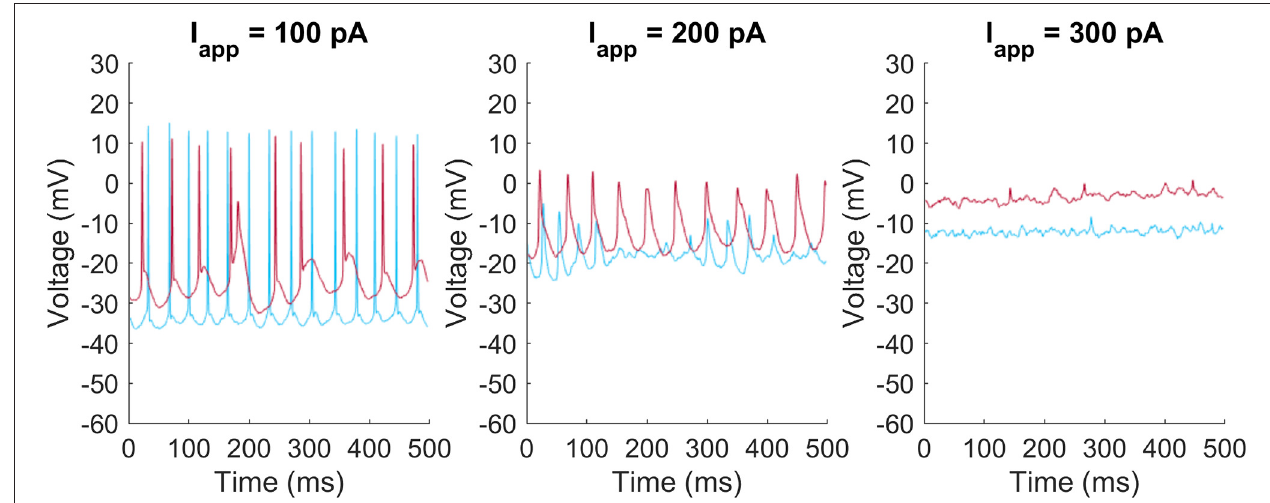
FIGURE 2 | Heterogeneity of firing patters in M1 ipRGCs. Two M1 cells (red and blue) respond at different rates and with different resting membrane potentials to injected currents of I app = 100pA (left) , 200pA (middle) , and 300pA (right) .